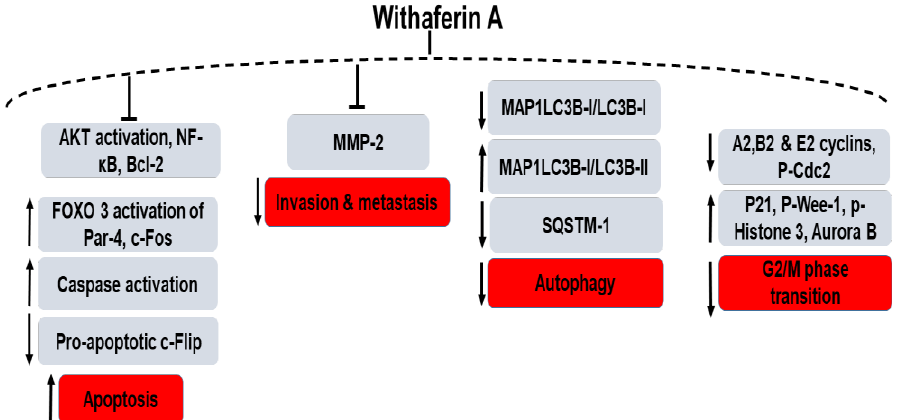
Figure 3. WFA’s role in the various signaling pathways of prostate cancer. “ ↑ ” denotes an increase, “ ↓ ” denotes decrease and “T” denotes inhibition.